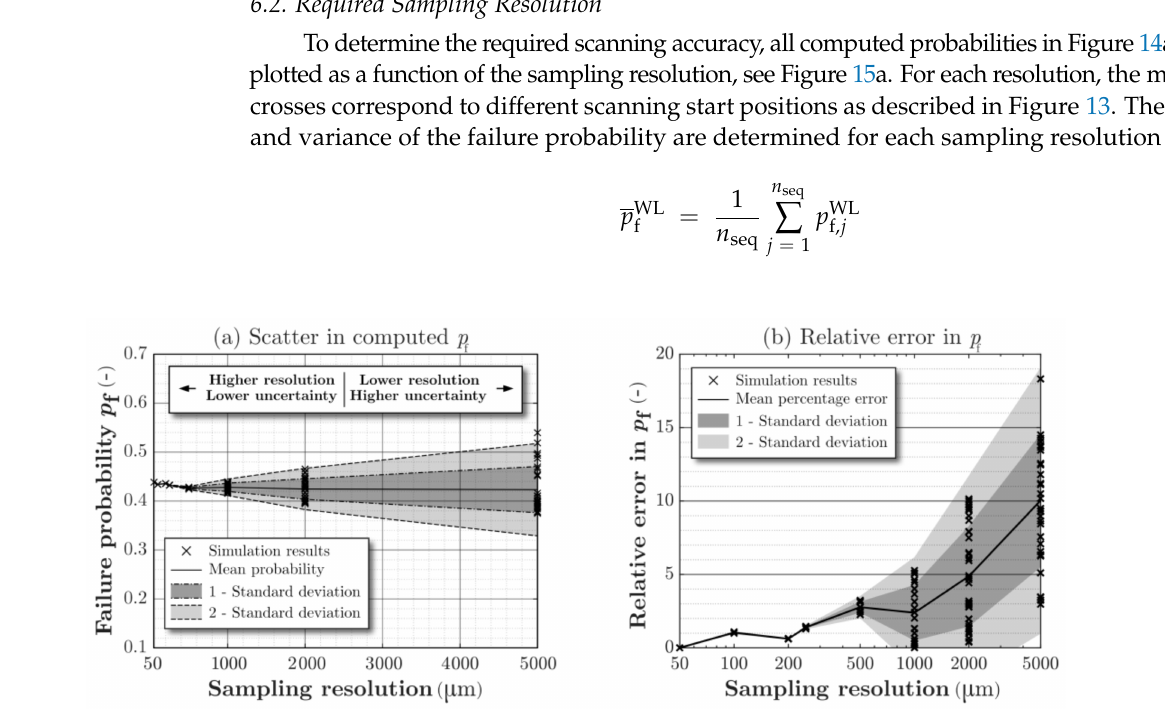
Figure 15. Influence of sampling resolution on ( a ) the computed Weakest-link failure probability of 1 digitally scanned specimen and ( b ) the relative absolute error in the computed probability with respect to the highest resolution (50 µ m). At each sampling resolution, different sampling sequences are marked by